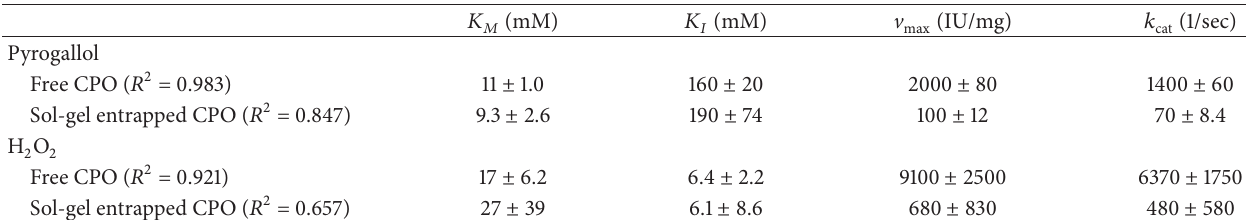
Enzyme kinetic parameters were obtained by fitting the data shown in Figure 1(a) (pyrogallol) and Figure 1(b) (H 2 O 2 ) to a substrate inhibition model (see (1)). All parameters are presented as value of the fit ± one standard error of the fit.